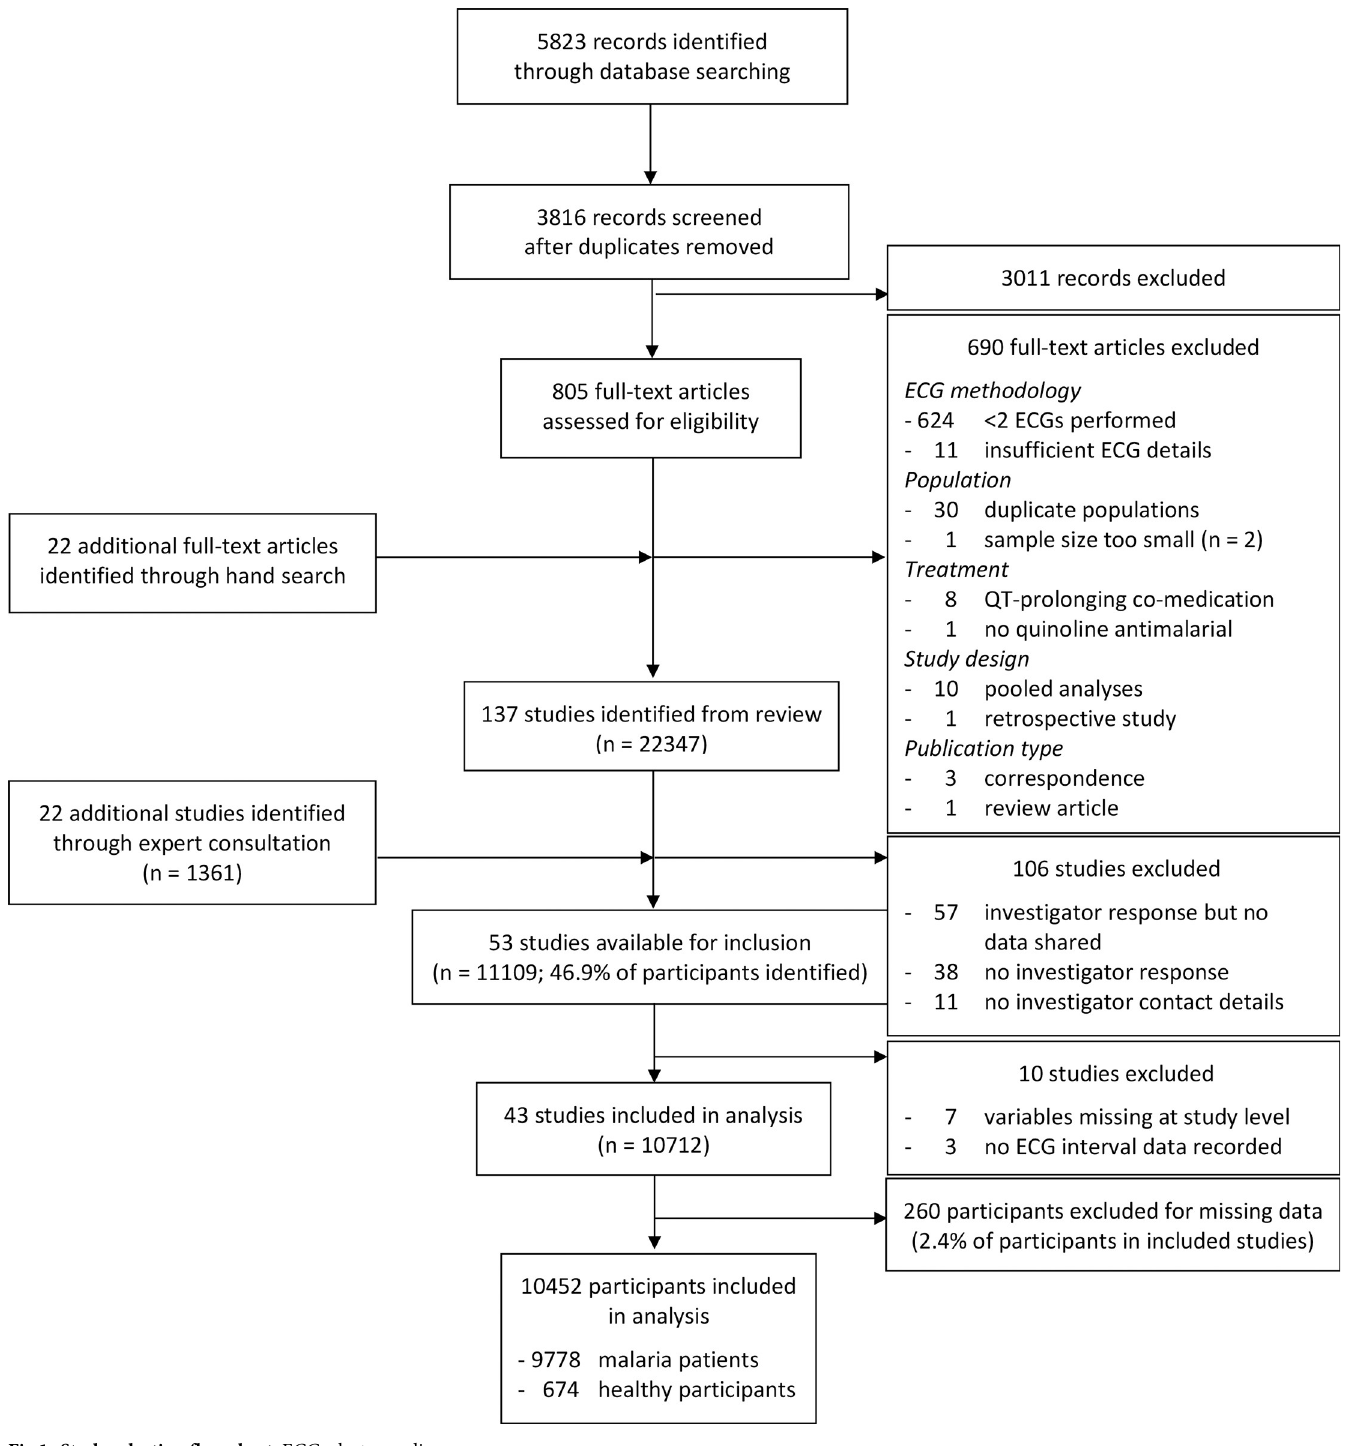
PLOS Medicine| https://doi.org/10.1371/journal.pmed.1003040 March 5,